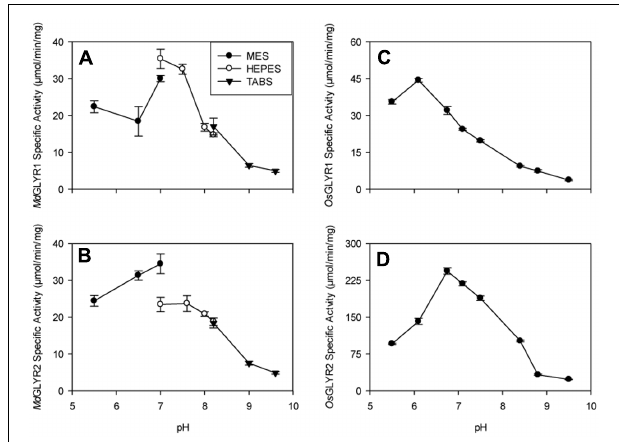
FIGURE 1 | Dependence of recombinant apple and rice GLYR activities on pH. The left and right panels, represent apple (A,B) and rice (C,D) GLYRs, respectively, whereas the upper and lower panels represent GLYR1s (A,C) and GLYR2s (B,D) , respectively. The data, expressed as specific activity ( µ mol min - 1 mg - 1 protein), were determined using 50 µ M glyoxylate and NADPH in thee buffers (50 mM each): 2-morpholino-ethanesulfonic acid, 4-(2-hydroxyethyl)-1-piperazineethanesulfonic acid and N -tris(hydroxymethyl)methyl-4-aminobutanesulfonic acid either separately (A,B) or together (C,D) . Each datum represents the mean ( ± SD) of three technical measurements of a typical enzyme